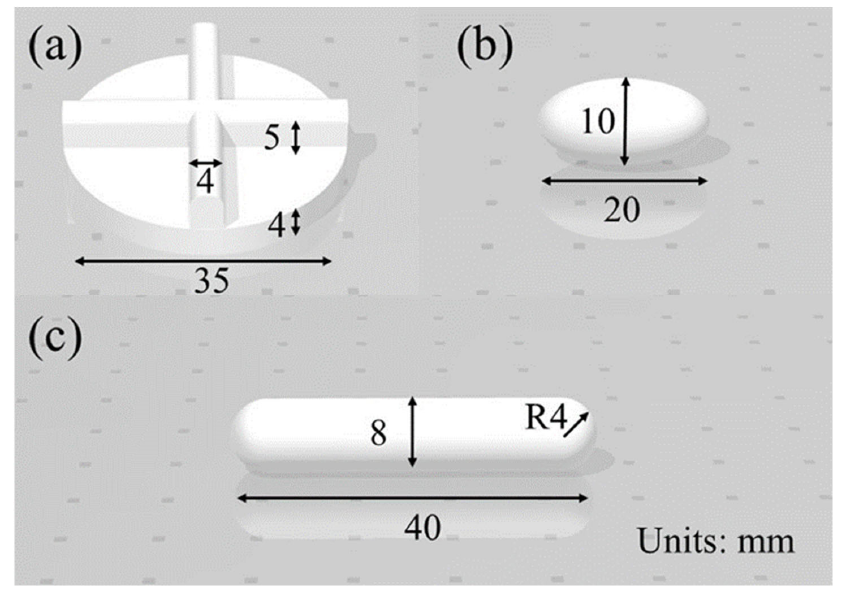
Figure 1. Dimensions of the three stirrers that were used in the experiments. ( a ) stirrer 1; ( b ) stirrer 2; ( c ) stirrer 3.